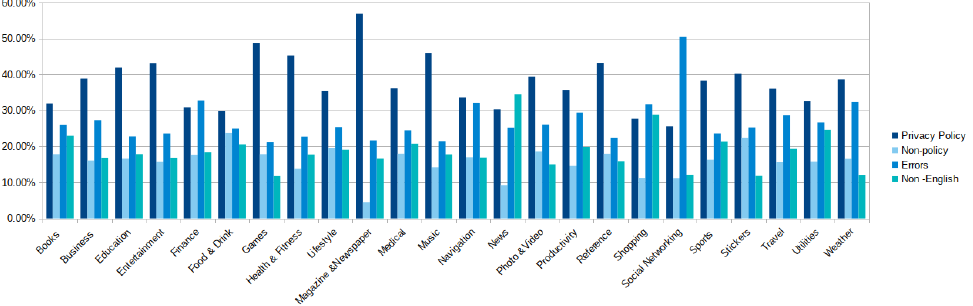
Figure 7. Overview of the broad classes of privacy policy links after